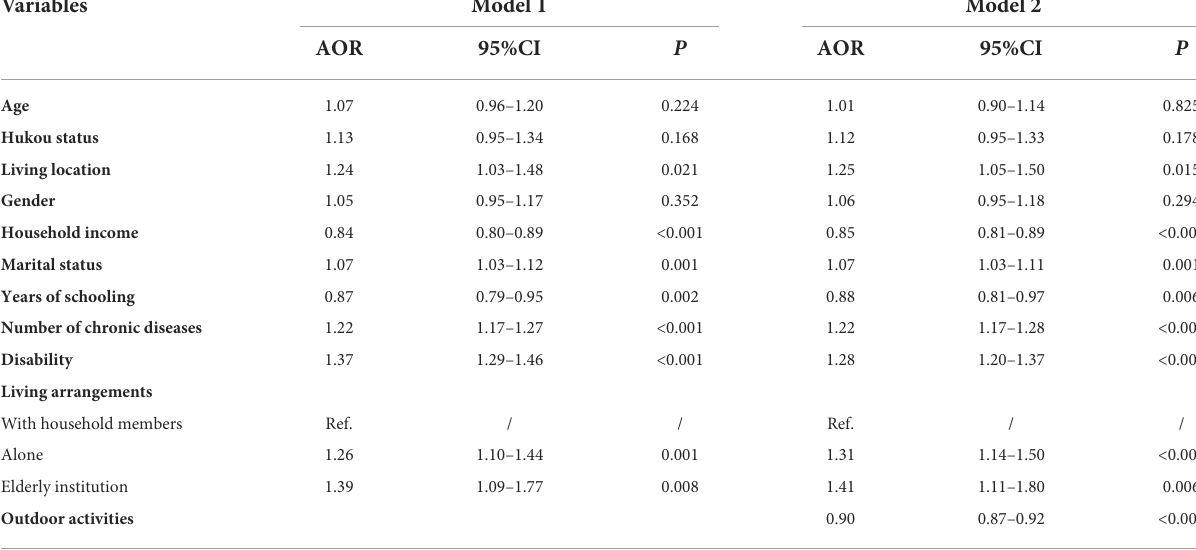
TABLE 2 Binary logistic regression for the association between living arrangements and depressive symptoms.